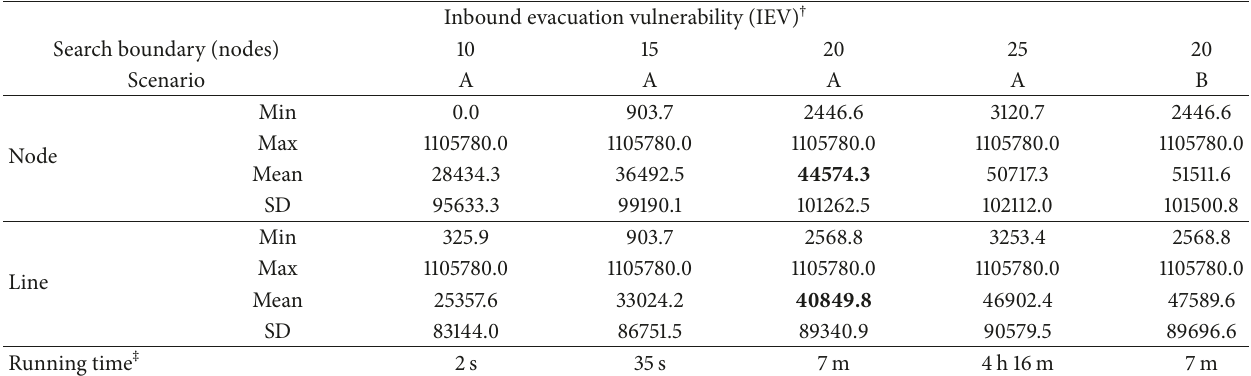
Table 2: Statistics of IEV in the scenario-based assessment.